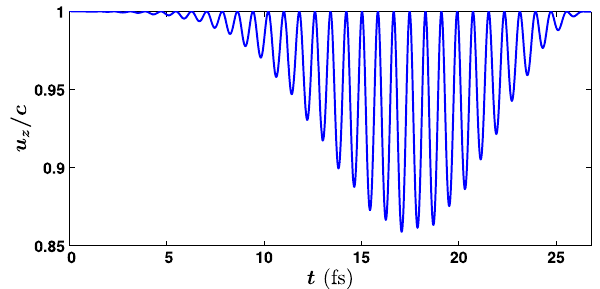
ð t Þ and P LAD ð t Þ for the sinusoidal- FIG. 8. Comparison of P rad rad envelope linearly polarized plane wave with parameters given in Fig. 4.